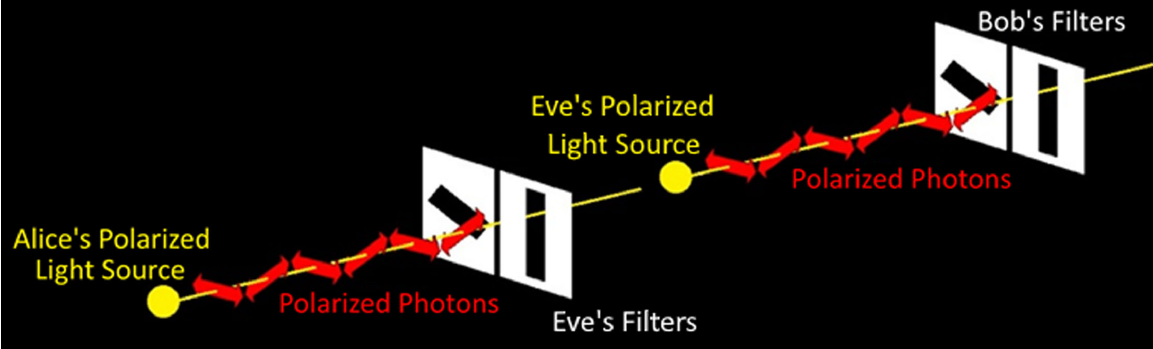
FIG. 1. Eve ’ s interference absorbs the original photon produced by Alice and requires her to generate a replacement photon to send to Bob to avoid detection.